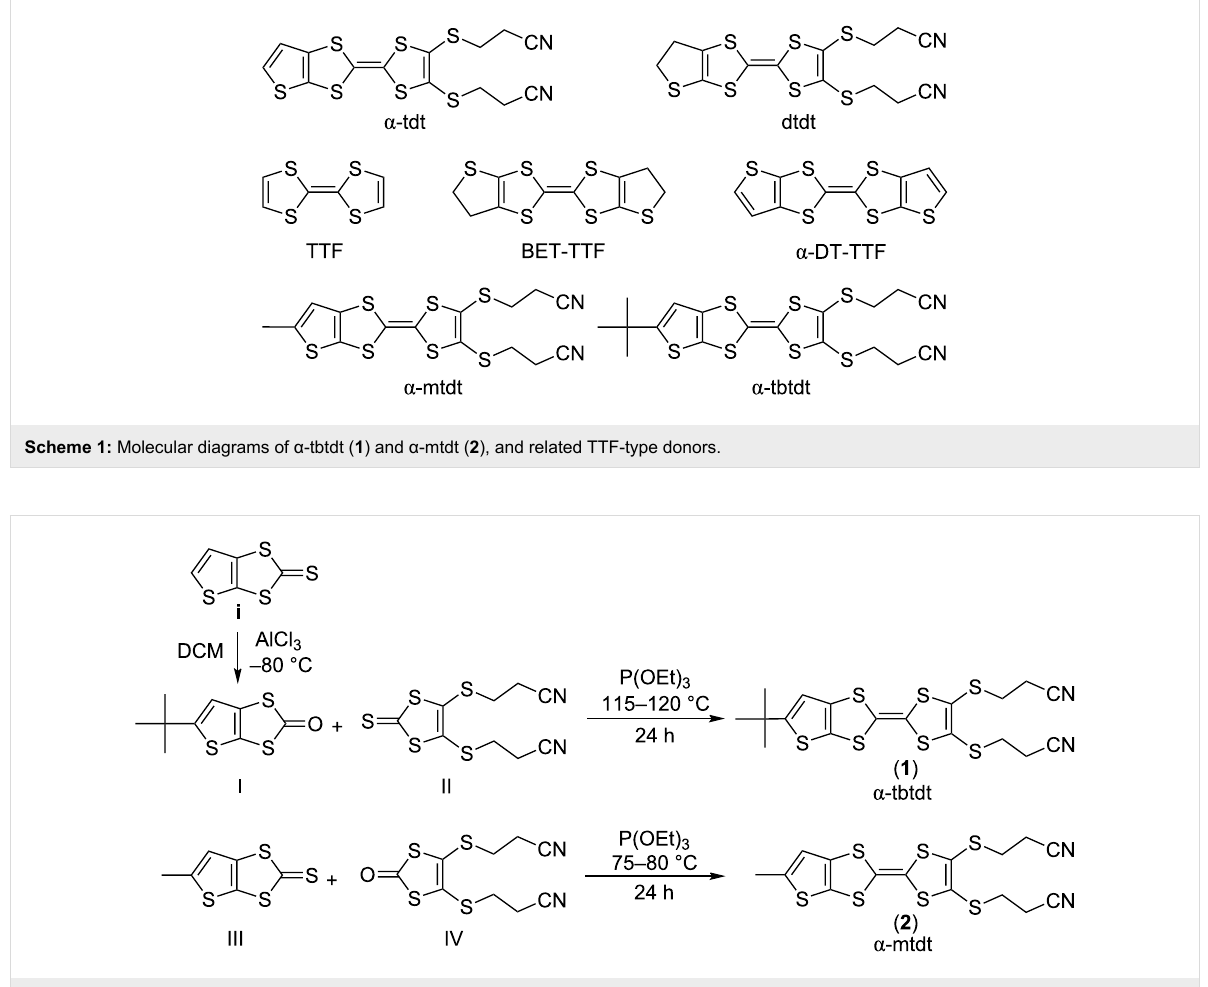
Scheme 2: Synthetic route for compounds 1 and 2